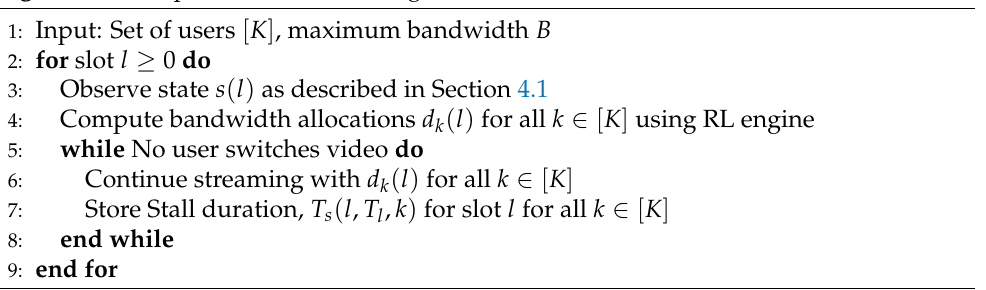
Algorithm 1 Proposed MA-Stream